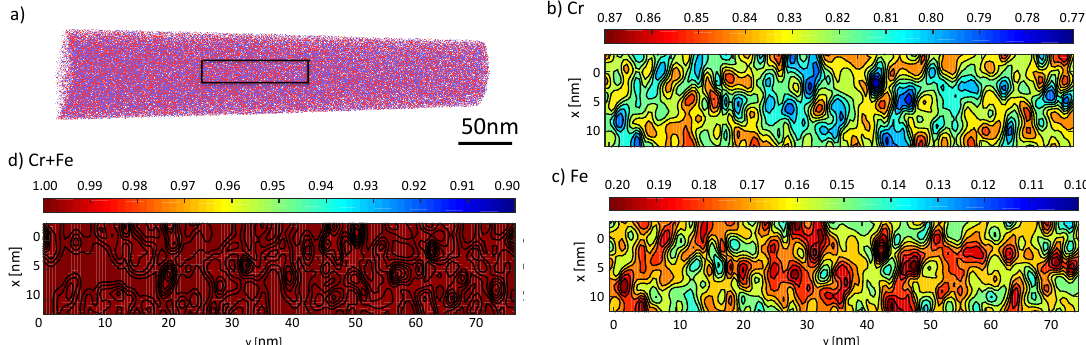
Figure 2. ( a ) Atom probe reconstruction of the Fe-Cr alloy, measured at 50K. The black box marks the area were the data for the 2D concentration maps ( b , c ) are taken from. Clearly visible are small clusters of Cr and Fe, respectively. The concentration distribution is integrated over a sample slice with a thickness of 2.5nm; ( d ) shows the summation of ( b , c ), which should sum up to 100%. The small differences of less than 1% are caused by impurities such as P, N, and